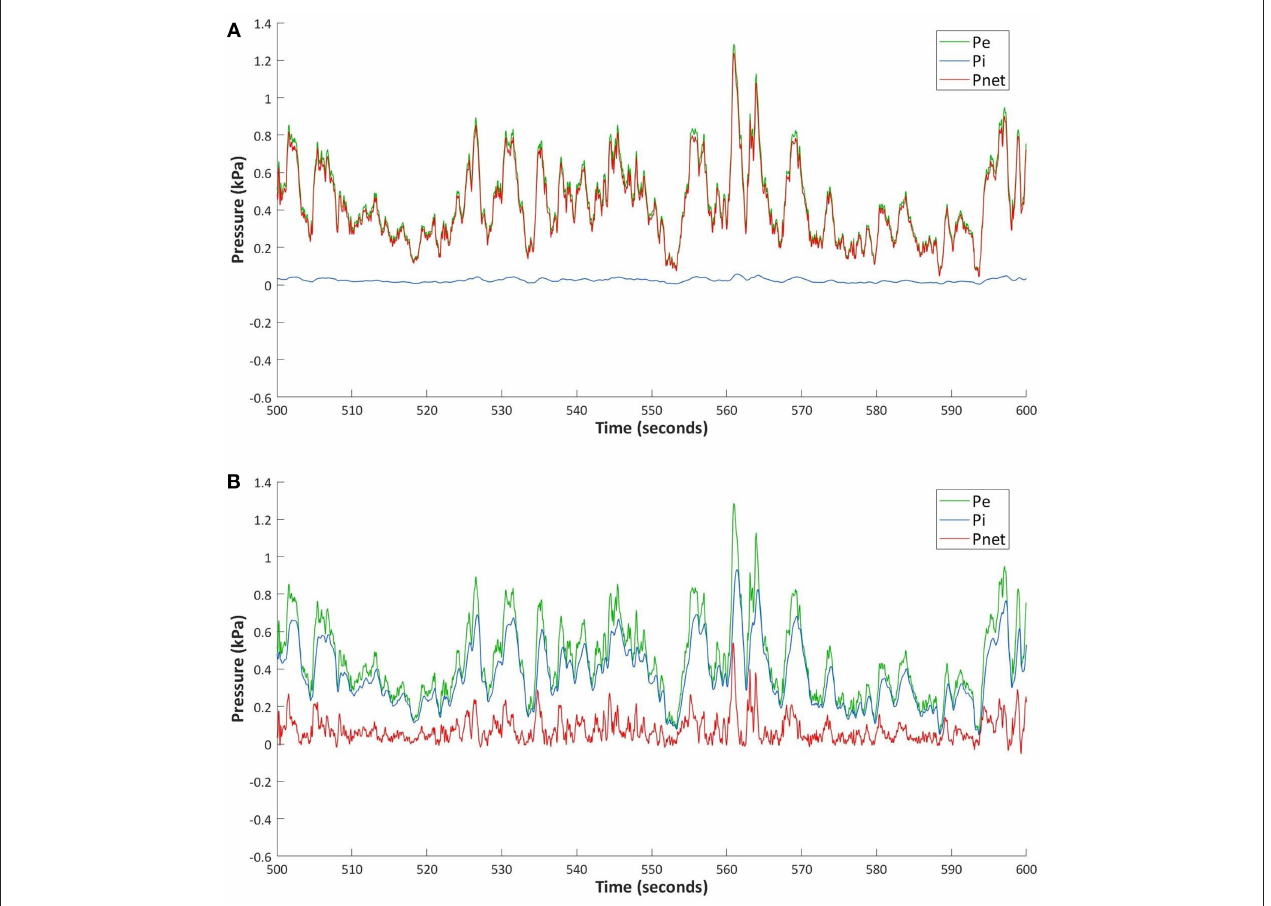
FIGURE 10 | Time-history of external, predicted internal, and net pressure over a small section of the time series of a garage door model with a fixed opening area of (A) 0.1% and (B)